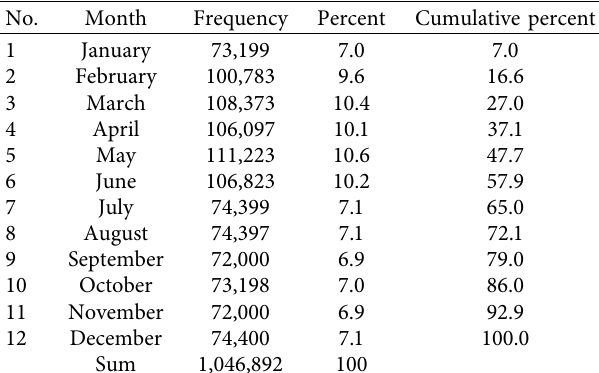
Table 4: Percentage of month in this study.